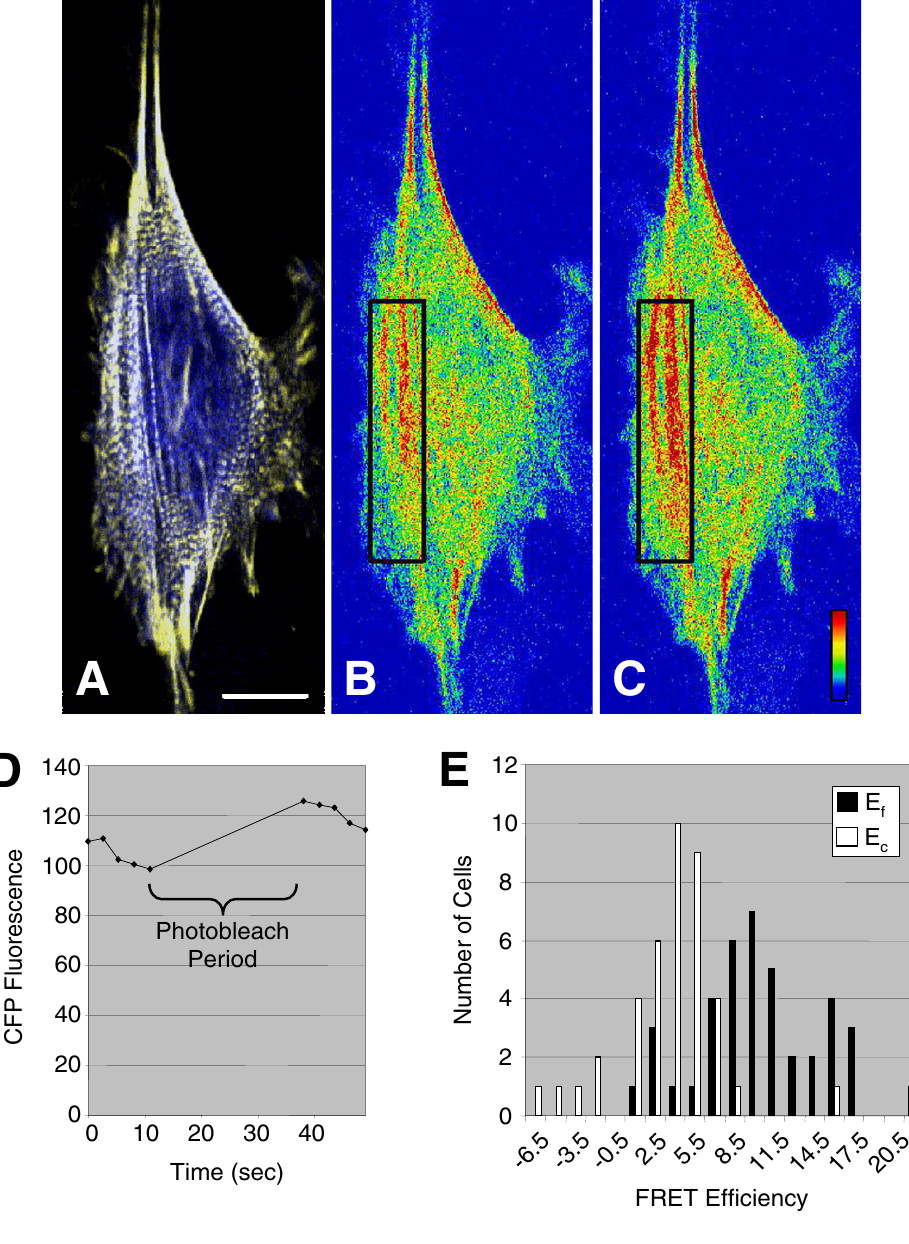
Figure 6 CRP1 binds α -actinin along actin stress fibers . REFs were co-transfected with pECFP-CRP1 and pEYFP- α -actinin and FRET microscopy carried out as described in Experimental Procedures. ( A ) Overlay image of cell expressing CFP-CRP1 and YFP- α -actinin showing the ROI that was photobleached during the FRET experiment. A color scaled image of the CFP fluores- cence of the cell prior to ( B ) and immediately following ( C ) the photobleaching period. Red represents a high signal and blue, a low signal. Bar = 10 µ m. ( D ) The intensity of the CFP fluorescence within the ROI was quantified for each image captured dur- ing the experiment. ( E ) The distribution of FRET efficiencies for the photobleached ROIs, E , were plotted on the bar c